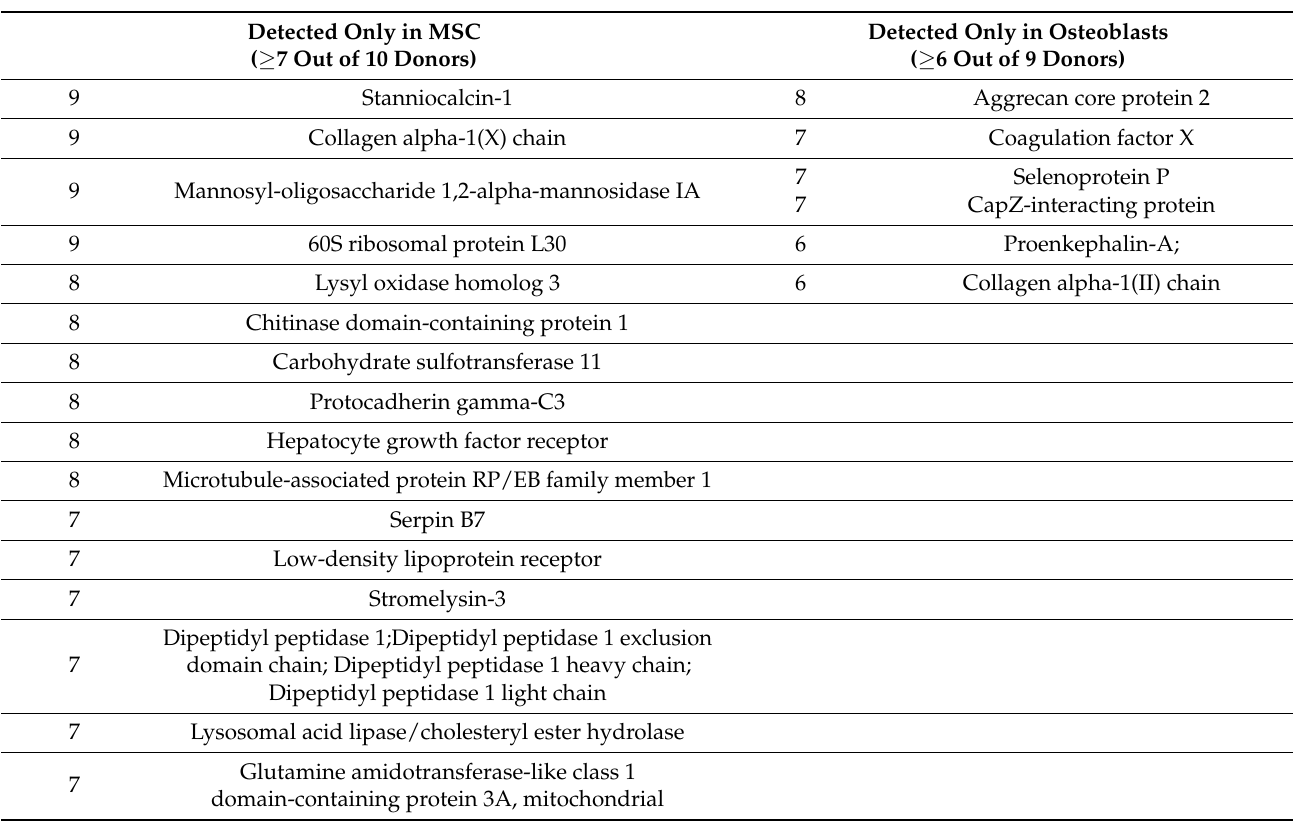
Table 4. Proteins showing qualitative differences when comparing MSCs and osteoblasts. For each of the two cell types, the table shows the number of donors with detectable levels (indicated to the left in each of the two main columns) together with the name of the